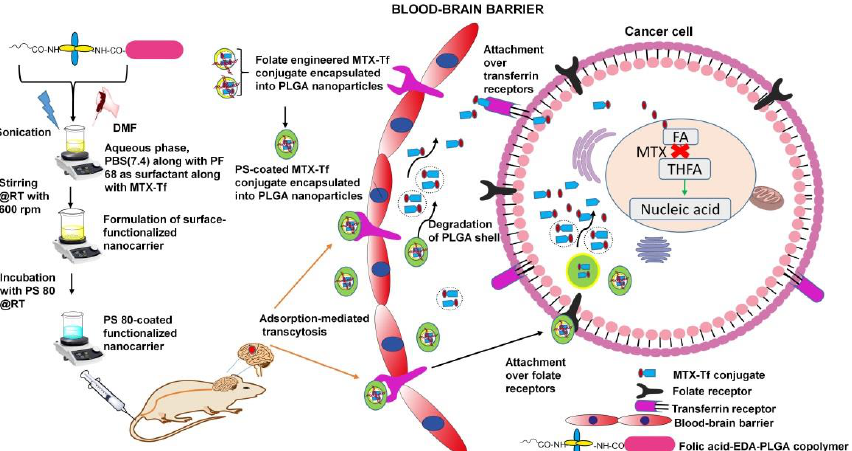
Figure 9. BBB crossing mechanism of PS 80-coated PLGA NPs loaded with methotraxate–transferrin prodrug conjugates. Redrawn and reproduced with permission from Reference [140].